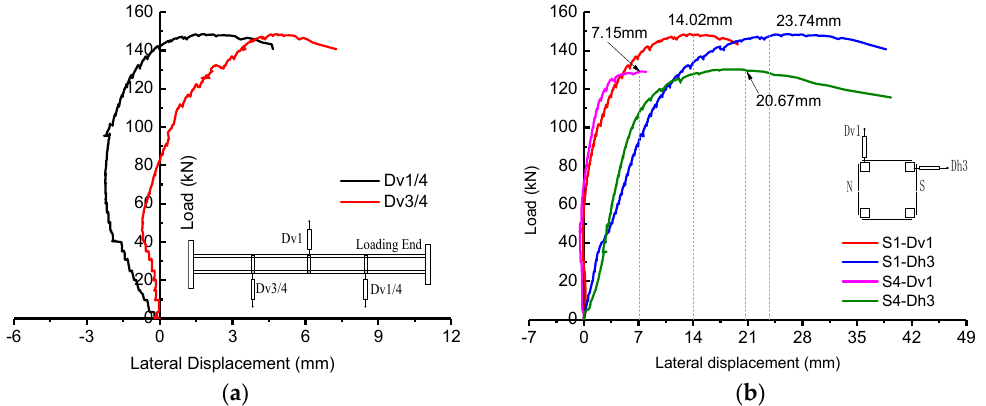
Figure 8. Load-lateral displacement curves: ( a ) Lateral displacement at quarter-length point of S1; ( b ) Lateral displacement at half-length point of S1 and S4.